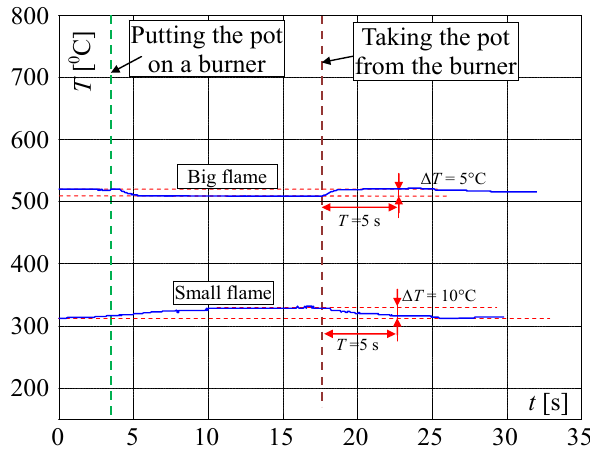
Figure 14. Temperature changes measured by the linear thermocouple located in position 3.